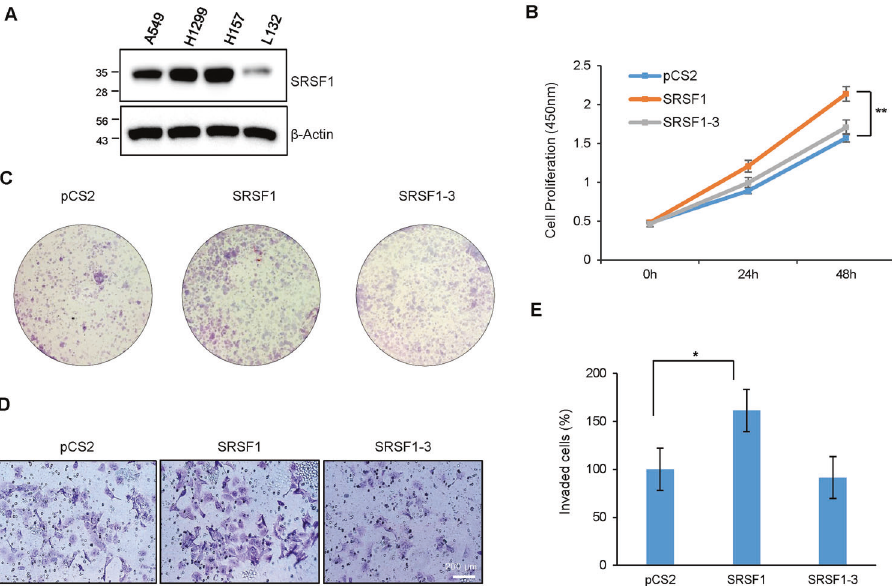
Fig. 4 The oncogenic role of SRSF1 is dependent on the alternative spliced isoforms. A The expression level of SRSF1 in the lung cancer cells A549, H1299, and H157 was higher compared to the normal lung epithelial cell. B H157 cells were transfected with either SRSF1 or SRSF1- 3 plasmids and cell proliferation was measured at the indicated time point. C SRSF1 or SRSF1-3 transfected H157 cells were reseeded in 30 mm plates following 24 h of post-transfection and continuously cultured until the appearance of visible colonies. The colonies were fi xed with methanol, stained with Giemsa stain, and imaged under a light microscope. D H157 cells were transfected with SRSF1 or SRSF1-3, harvested after 48 h, and reseeded on a matrigel containing transwells. After 24 h of incubation, invaded cells on the lower chamber of the transwell were fi xed, visualized with Giemsa stain, and imaged using a light microscope. E The percentage of invaded cells was measured and data from three independent experiments are shown in the bar graph. ( *P < 0.05 and **P < 0.01, two-tailed student ’ s